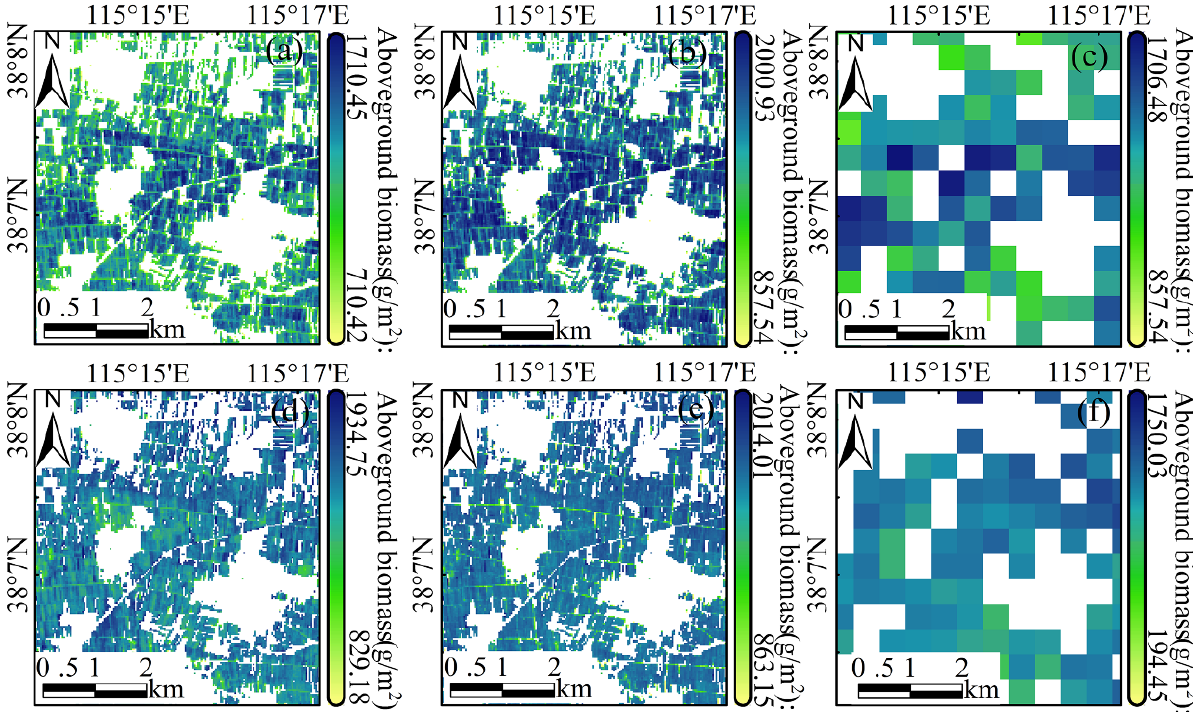
Figure 16. Spatial distribution of aboveground biomass of different crops. ( a – c ) Aboveground biomass of winter wheat derived by improved CASA model, original CASA model and MODIS FPAR product. ( d – f ) Aboveground biomass of summer maize derived by improved CASA model, original CASA model and MODIS FPAR product.